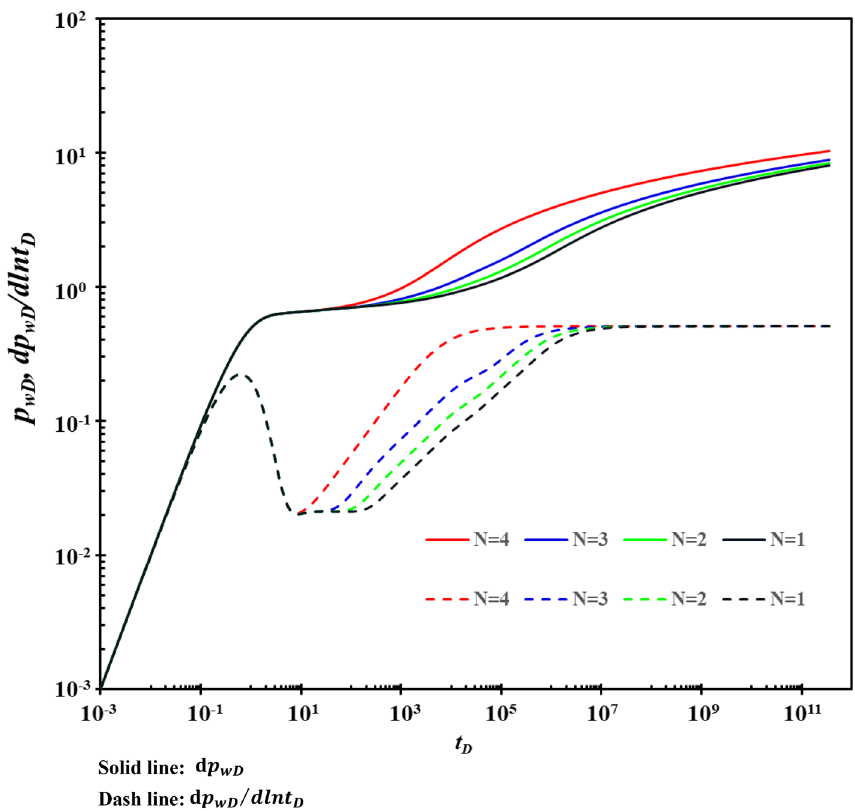
Figure 14. The effect of the number of fractures on type